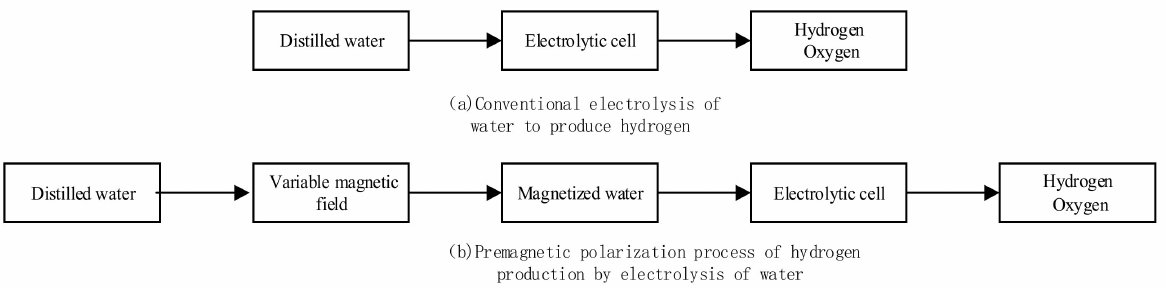
Figure 2. Comparison of conventional hydrogen production from water electrolysis and pre- magnetic